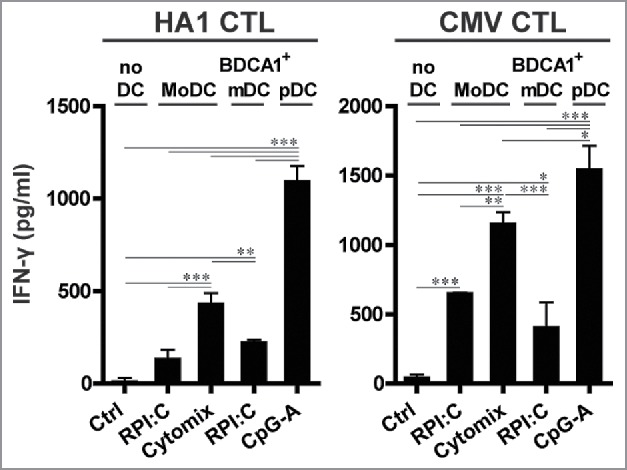
HSPC-derived pDCs show superior capacity to induce IFN-γ secretion by CD8+ Tem cells. HSPC-DCs were generated and activated as described in Fig. 3. TLR-matured DCs were seeded in triplicate and loaded for 1 h with 1 µM HA1 or CMV peptide at 37°C. Next, without washing, CTLs specific for HA1 or CMV were added at 1:1 ratio and co-cultured for 24 h. Concentrations of IFN-γ were determined by ELISA. Results are depicted as mean ± SD of a representative experiment (HA1 CTL: n = 2, CMV CTL: n = 1). Statistical analysis was performed by one-way ANOVA, followed by Bonferroni post-hoc test *p < 0.05, **p < 0.01, ***p < 0.001.